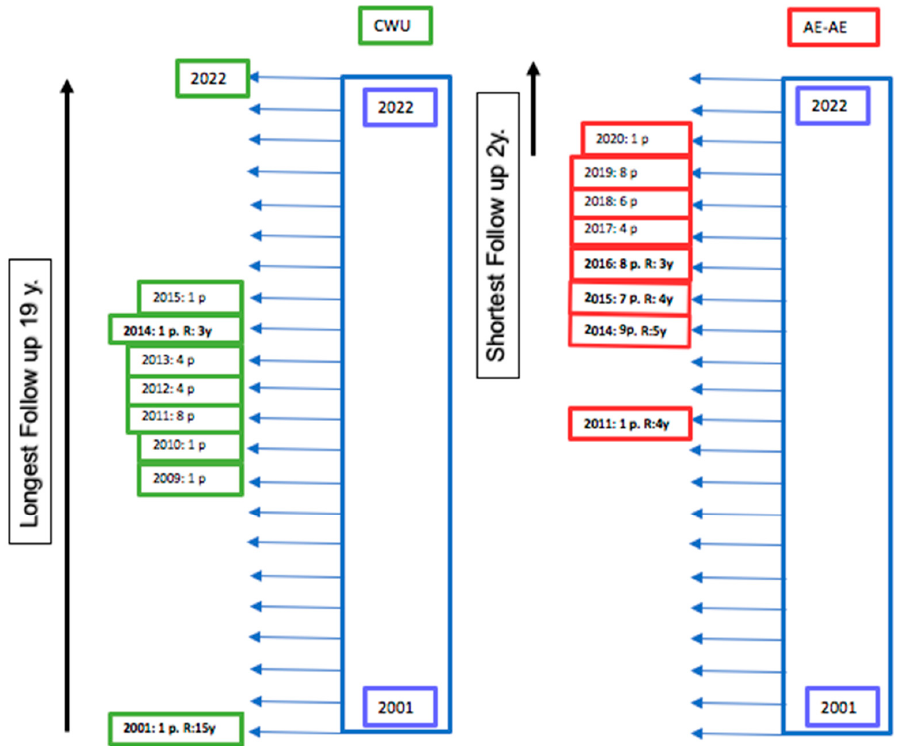
Figure 2. Scheme of patient inclusion, follow-up, and year of recurrence. CWU (in green) resulted in 2 patients with recurrence, and AE-AE (in red) resulted in 4 patients with recurrence. p: patients; R: recurrence. Table 2. Clinical, surgical, and recurrence characteristics according to type of surgery. Type of Surgery